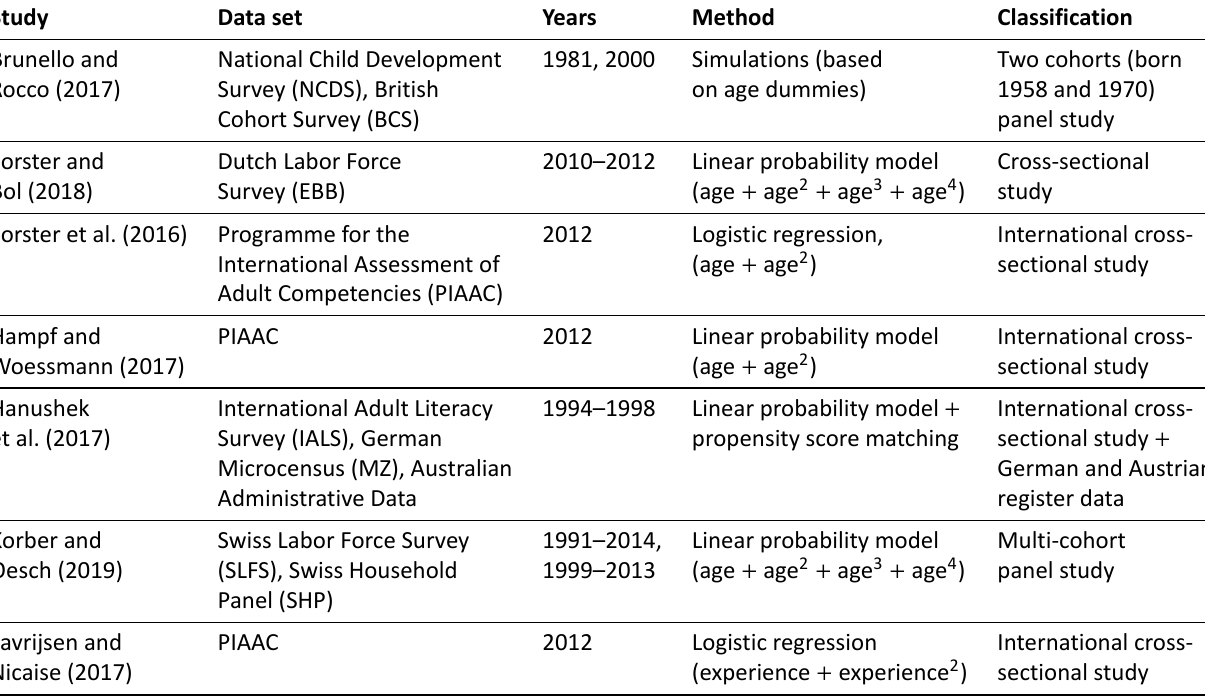
Table 1. State of research, data, and